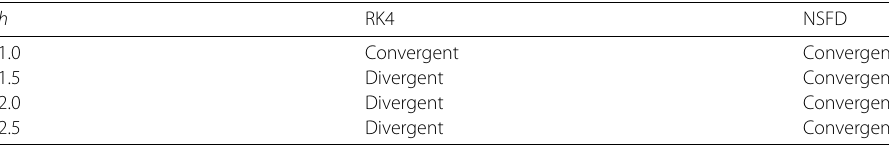
Table 2 Comparison of RK4 and NSFD numerical schemes h RK4 NSFD